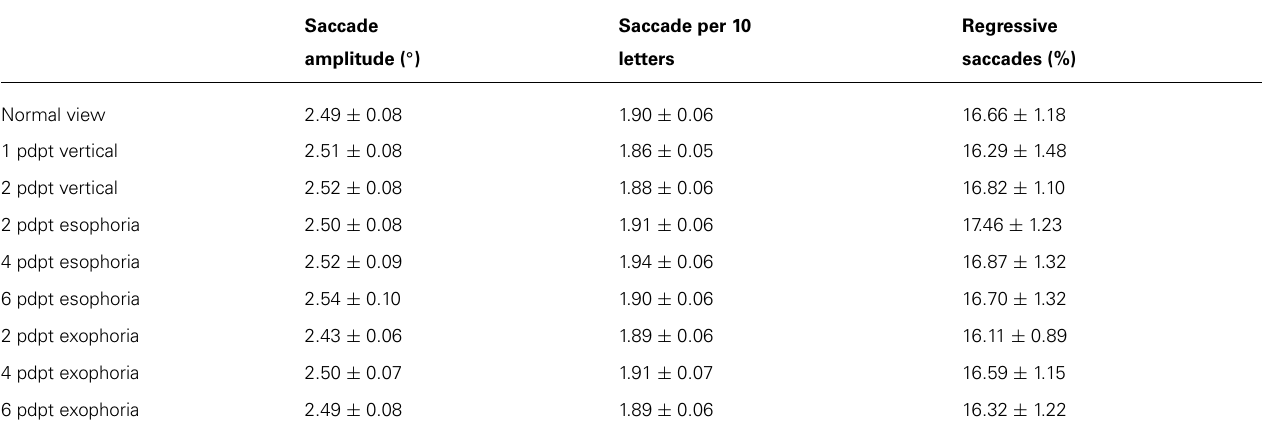
Table 2 | Mean saccade amplitude, saccades per 10 letters and percentage of regressive saccades ± standard error of the mean for normal view and all prism